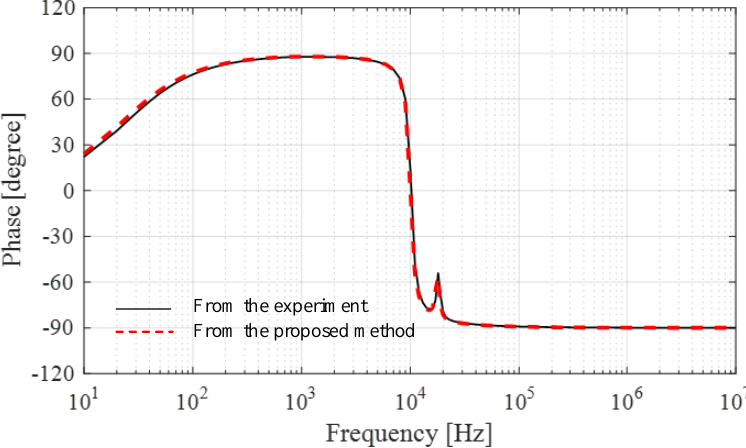
Figure 26. Phase of input impedances of the transformer winding from the measurement and by the proposed method.